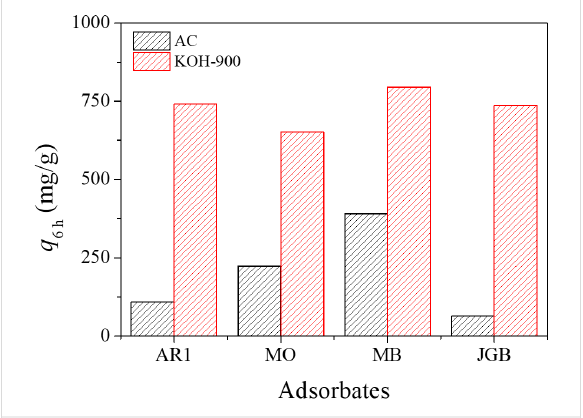
Figure 4: Adsorbed quantities of acid red 1 (AR1), methyl orange (MO), methylene blue (MB) and Janus green B (JGB) over AC and